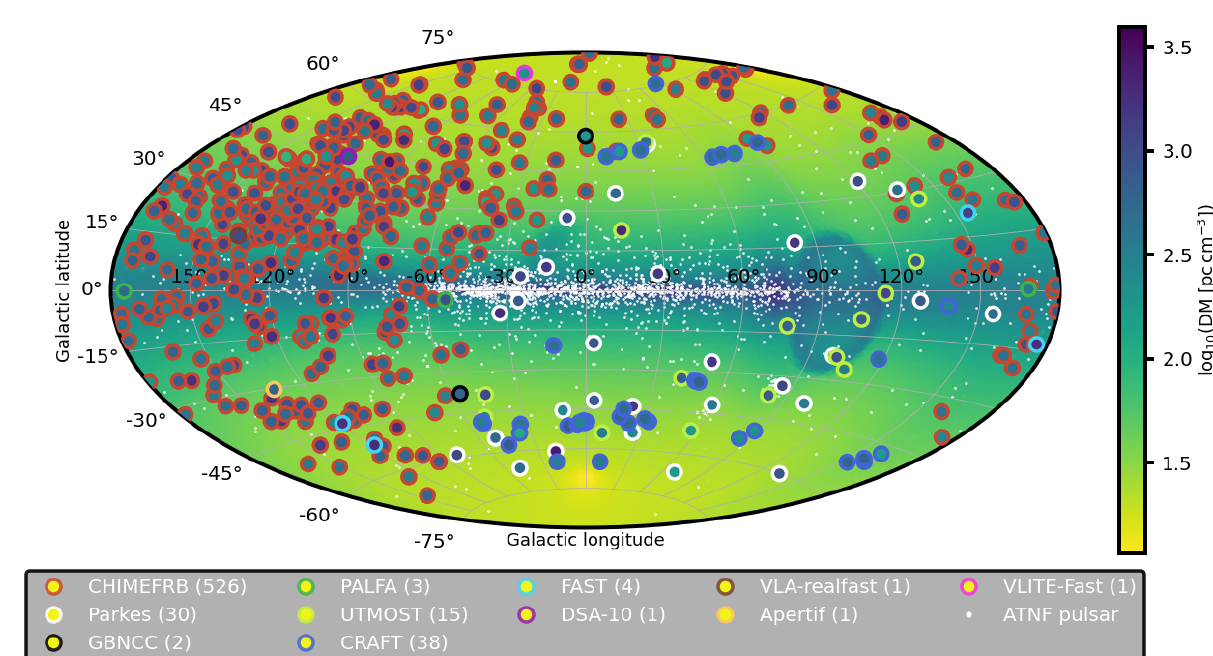
Figure 3. Aitoff projection of the all-sky distribution of FRBs detected by various telescopes across the world. The Galactic electron density distribution [28] is shown in the background. The FRBs are denoted by circles and follow the same color scale as the background. Any given FRB is observed to have a DM in excess of the Galactic contribution. The distribution of FRBs is almost isotropic. Any biases in the spatial distribution are likely due to differences in various survey depths and sky coverage. Credit: Laura Driessen.